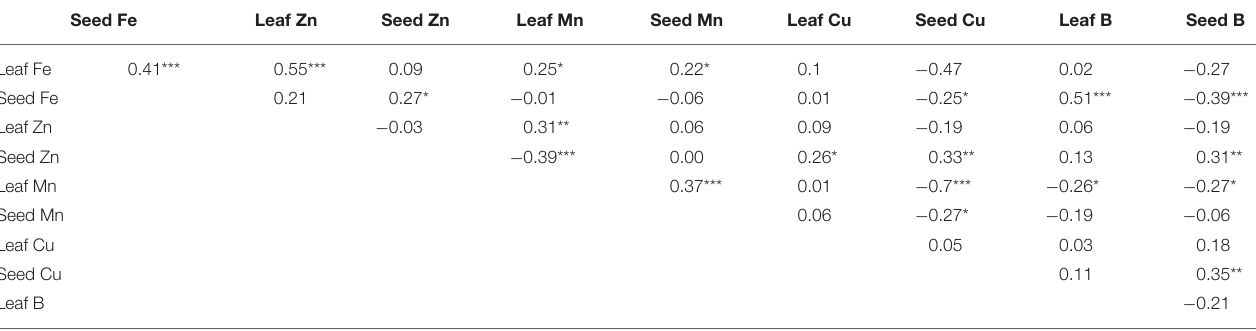
TABLE 3 | Correlation among micronutrients in cowpea leaves and seeds. Seed Fe Leaf Zn Seed Zn Leaf Mn Seed Mn Leaf Cu Seed Cu Leaf B Seed B Leaf Fe 0.41***